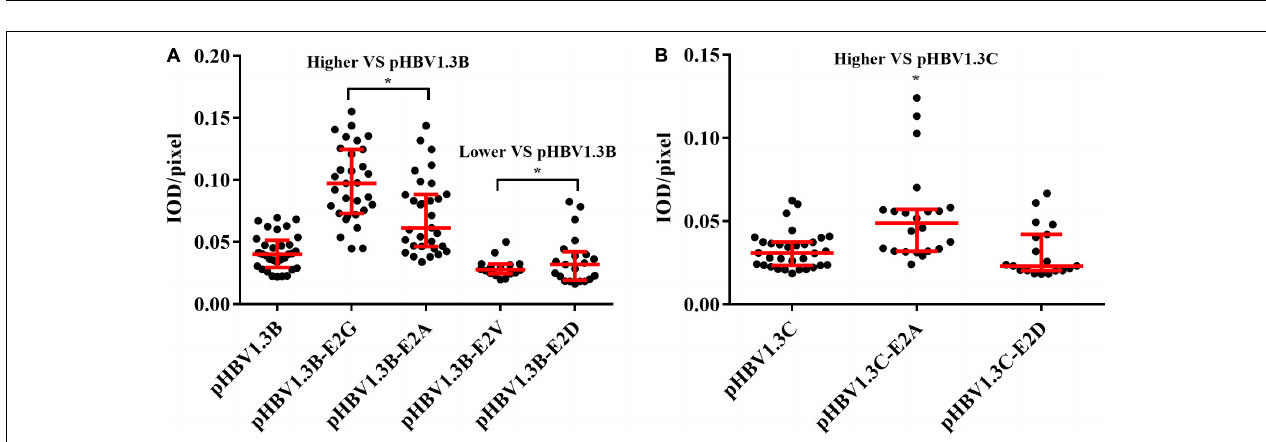
FIGURE 3 | Comparison of fluorescence intensity of HBsAg between E2 mutated plasmid and pHBV1.3B/C. Compared with pHBV1.3B, the fluorescence density of cells transfected with pHBV1.3B-E2G and pHBV1.3B-E2A was significantly higher ( p < 0.0001), while pHBV1.3B-E2V and pHBV1.3B-E2D was significantly lower ( p < 0.05) (A) . Compared with pHBV1.3C, the fluorescence density of cells transfected with pHBV1.3C-E2A was significantly higher ( p < 0.001). No significant changing was found between pHBV1.3C-E2D and pHBV1.3C (B) . The positive fluorescent cells transfected with pHBV1.3C-E2G were too few to be included in the fluorescence intensity statistical analysis. Fluorescence density = integrated optical density (IOD)/pixel. Integrating optical density (IOD) refers to the sum of the optical density values of each pixel in the area of the cross-sectional image of the cell. * p < 0.05. Mock: pcDNA3.1(+) vector.